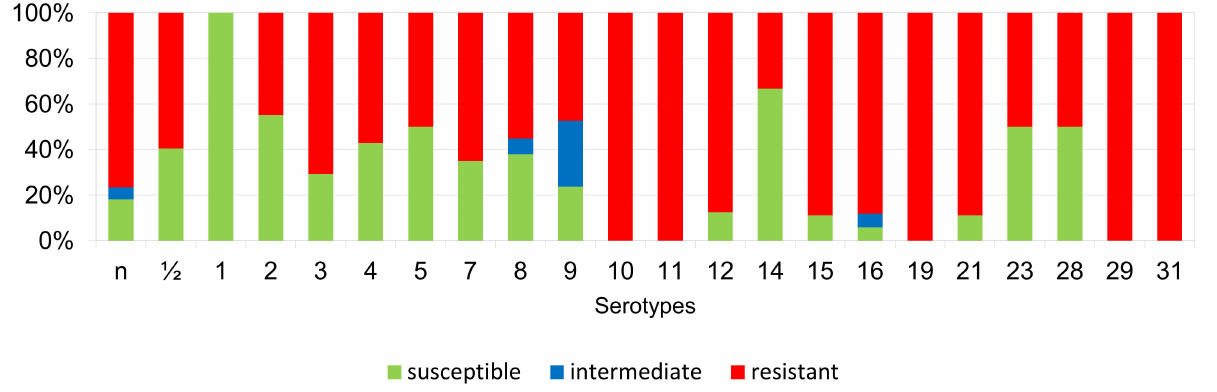
Figure 9. Percentage representation of isolates resistant, intermediately resistant, and susceptible to clindamycin belonging to individual S. suis serotypes from the Czech Republic during 2018–2022 ( n = 506). n = non-typeable isolates.